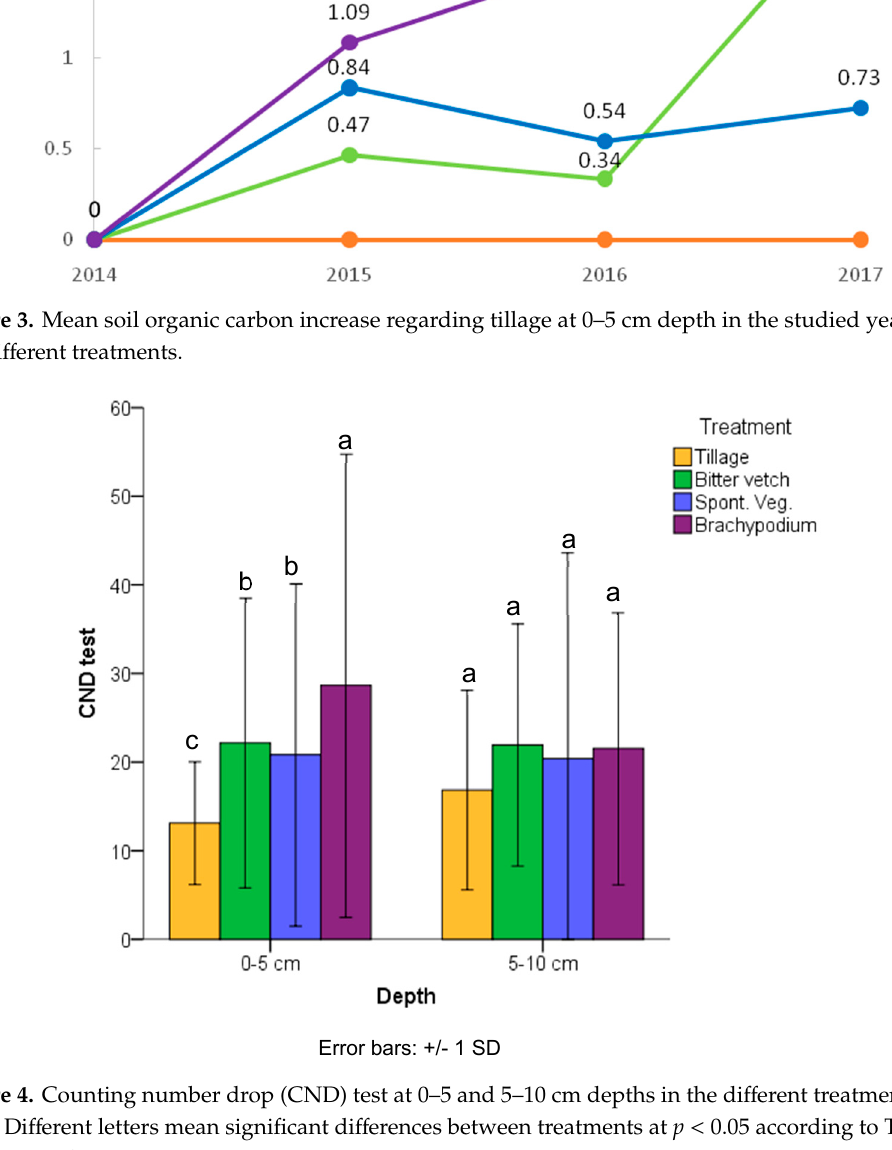
Figure 3. Mean soil organic carbon increase regarding tillage at 0 – 5 cm depth in the studied years in the different treatments.